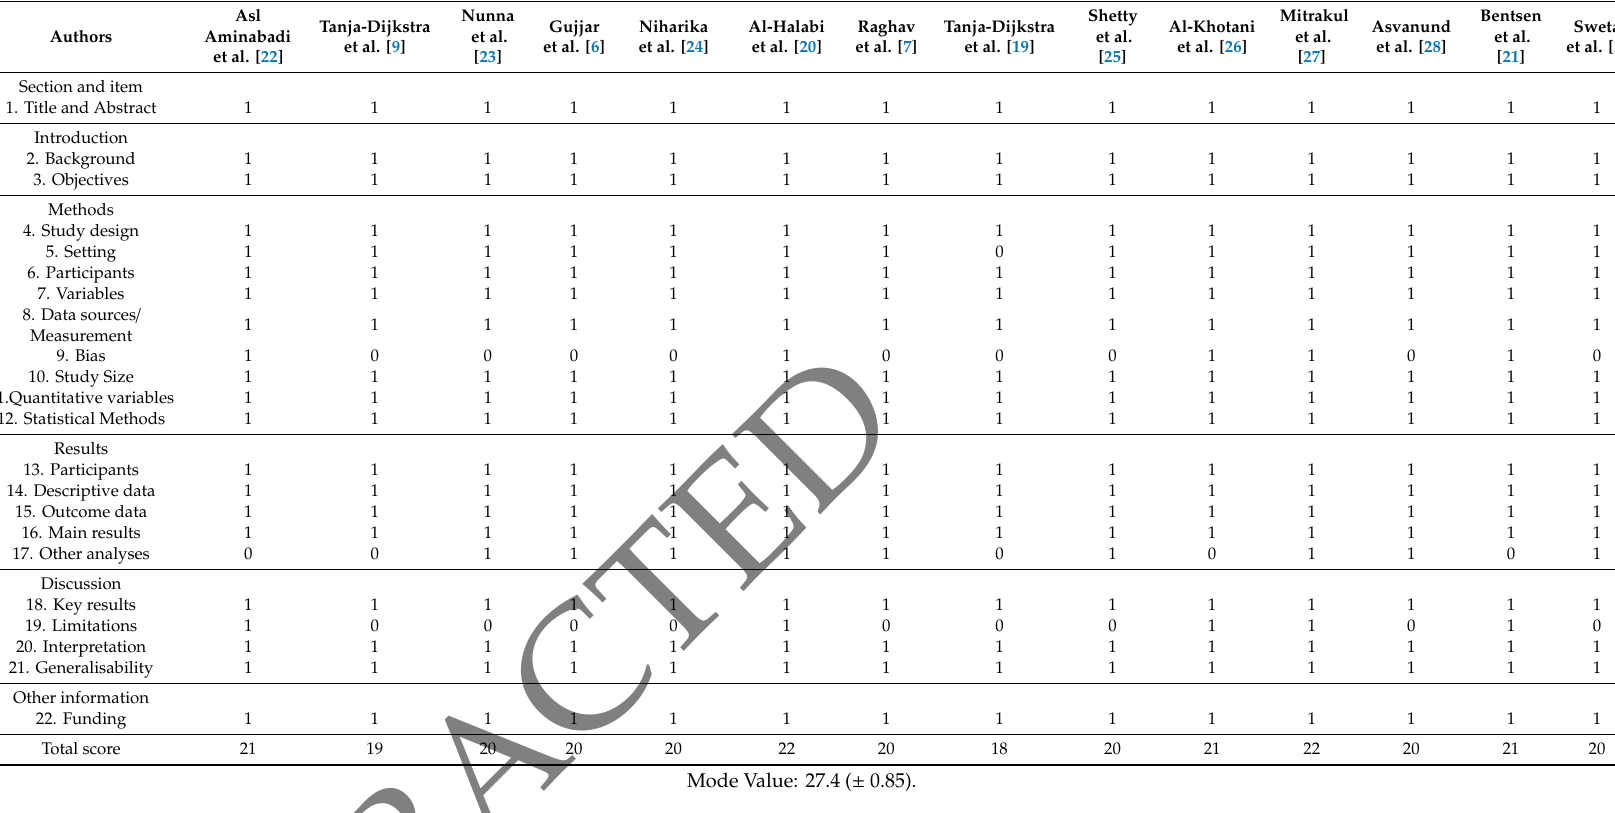
Table 1. Checklist of Reporting of Observational studies in Epidemiology (STROBE) criteria reported by the included studies. Each item was judged as “0” (not reported) or “1” (reported). The total score of each of included studies was also